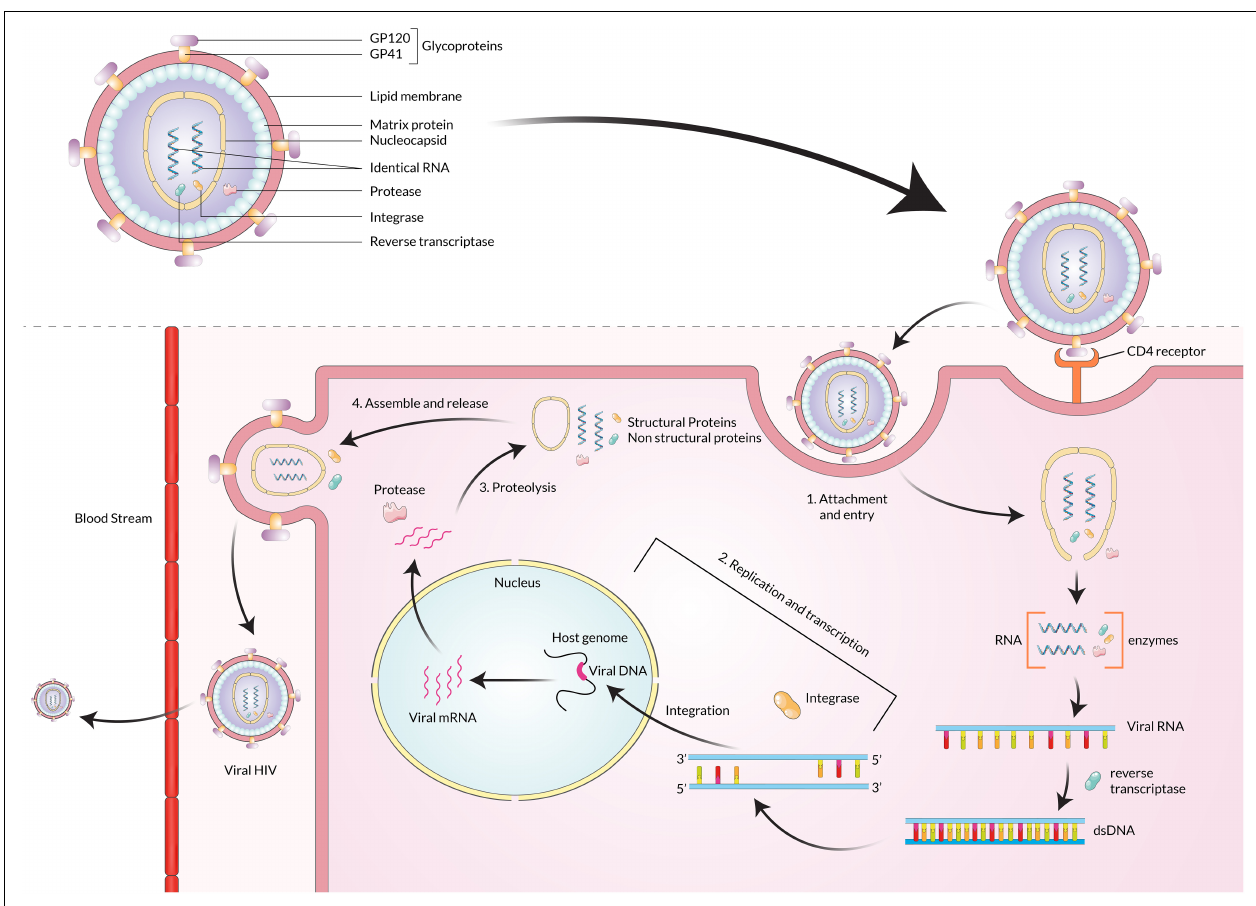
FIGURE 1 | After HIV GP120 binds with the receptors on the CD4 cell surface, the viral particle fuses with the membrane and enters the cell. The HIV genome ssRNA is reverse transcribed into the dsDNA using reverse transcriptase. The viral DNA is then integrated with the host cell DNA using integrase. The various structural and non-structural proteins are produced from the integrated DNA, and then viral particles are assembled and released from the